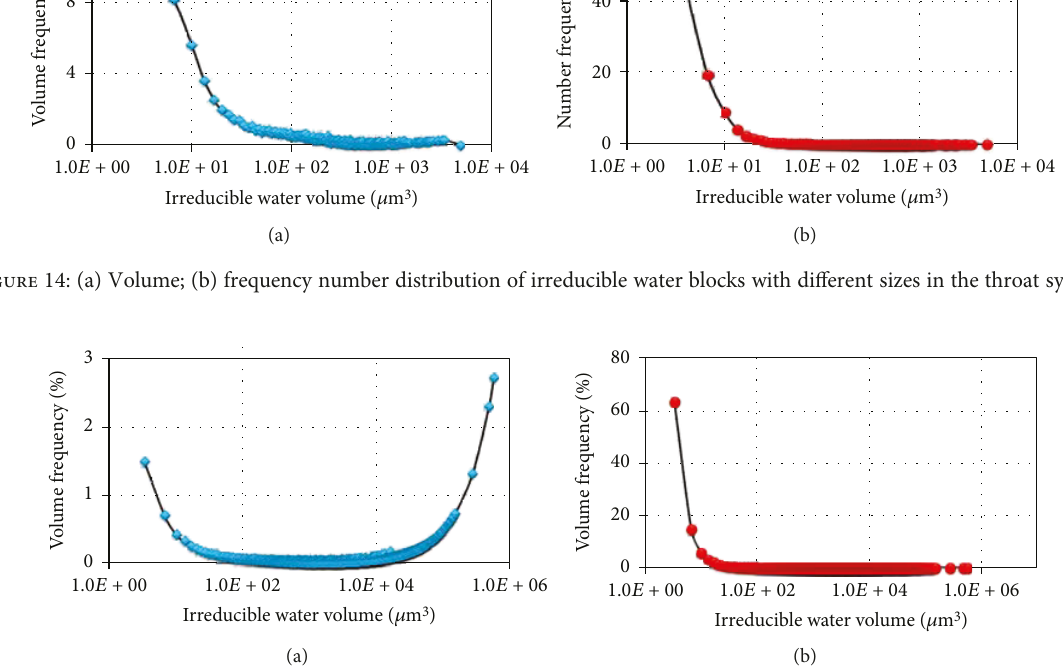
Figure 15: (a) Volume; (b) frequency number distribution of irreducible water blocks with di ff erent sizes in the pore system.